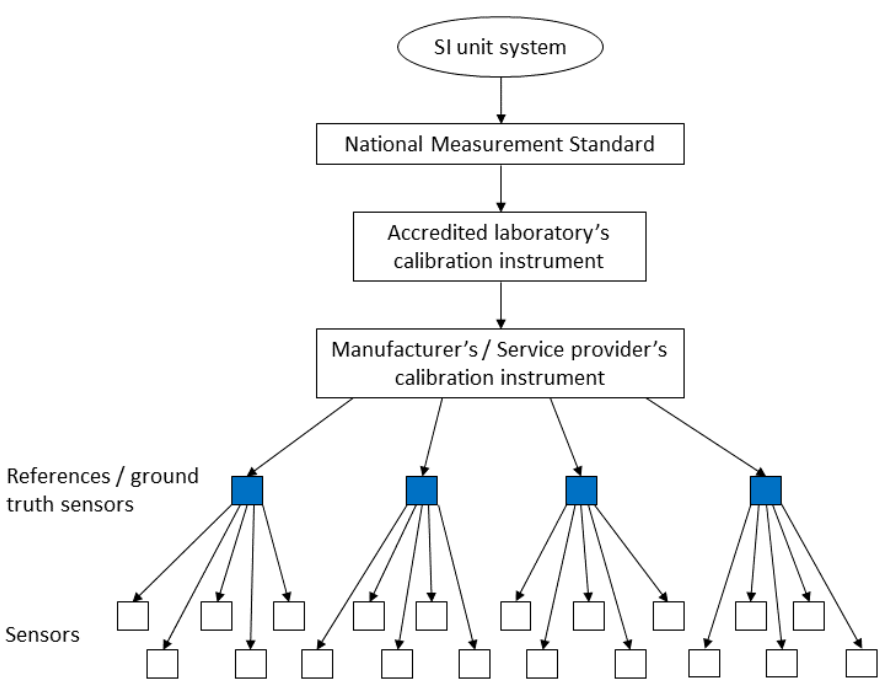
Figure 4. Traceability in an IoT sensor network.